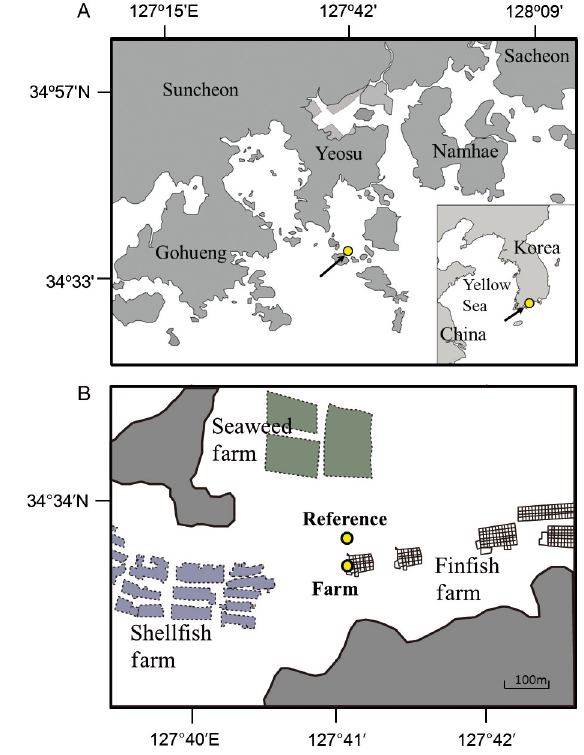
Fig. 1. (A) Study area in the coastal waters near Yeosu, South Korea; (B) ‘ farm ’ indicates the sampling site where sediment samples were taken directly underneath the fish cages, whereas ‘ reference ’ denotes the sampling site located ~50 m away from the fish